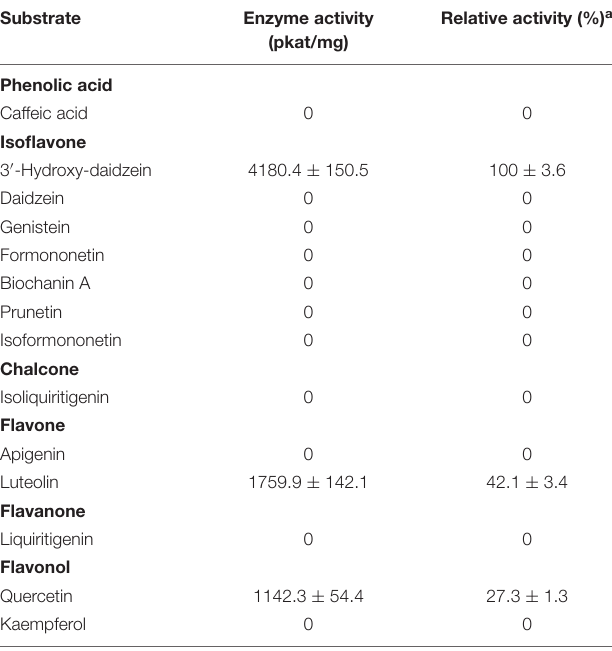
TABLE 1 | Enzymatic activities of the purified recombinant PlOMT4 toward a range of substrates in vitro .